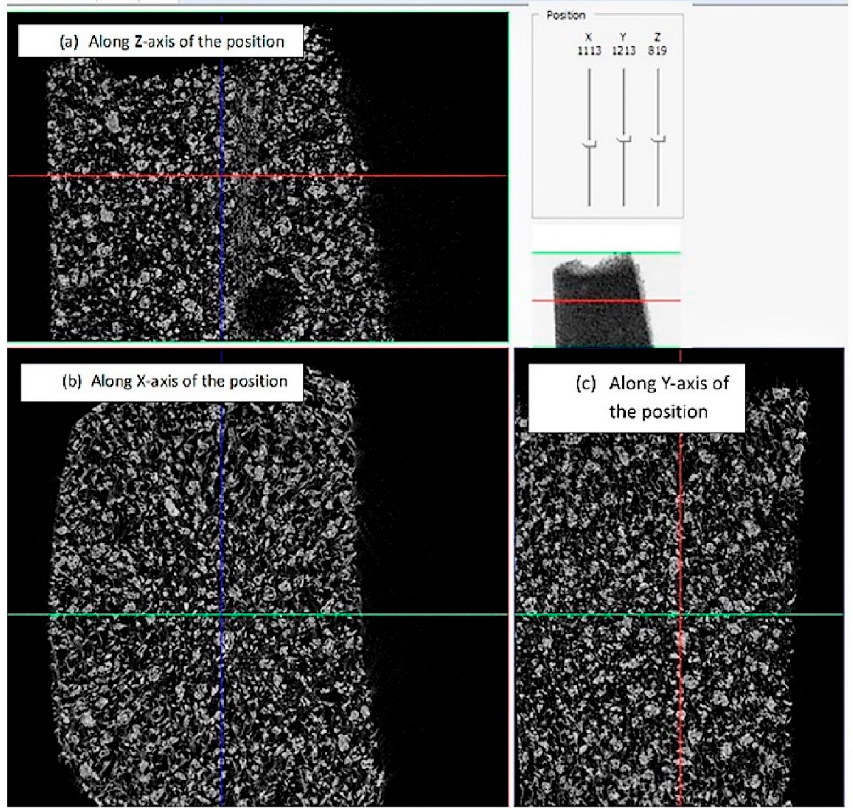
Figure 13. 2D frame of the filler distribution in MRE composite in Z (a), X (b), Y (c) direction. Reprinted from [18], © 2018 with permission from MPDI.